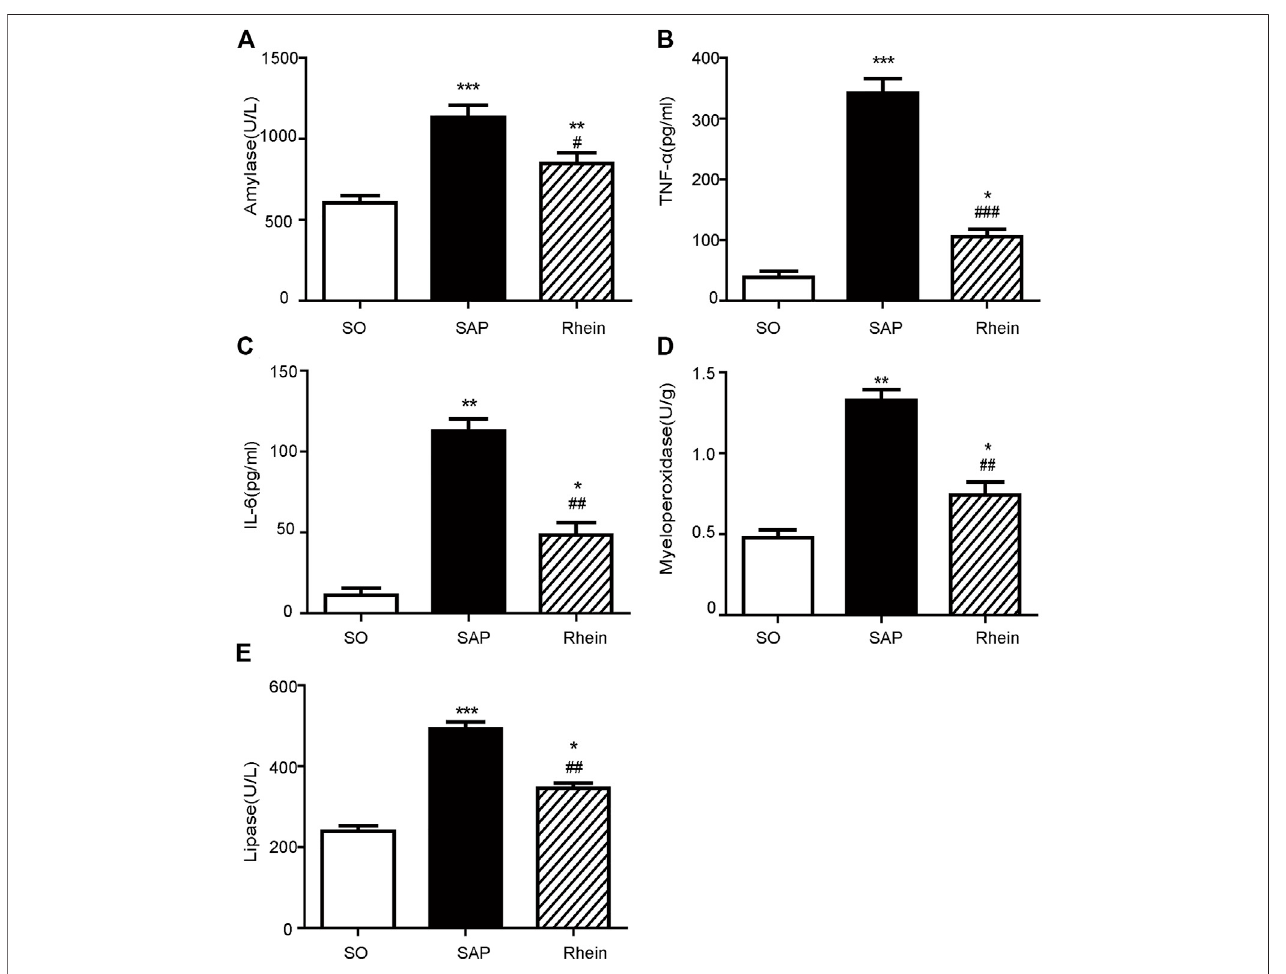
FIGURE3| Effectsofrheinonthein fl ammatorycytokinelevelsinpancreatictissueoftheSAPratmodel. (A) SerumamylaselevelsintheSO,SAPandrheingroups. (B) Serum TNF- α levels in the SO, SAP and rhein groups. (C) Serum IL-6 levels in the SO, SAP and rhein groups. (D) Myeloperoxidase levels in the SO, SAP and rhein groups. (E) SerumlipaselevelsintheSO,SAPandrheingroups.Dataareexpressedasmean±SD( n =5pergroup).Signi fi cancebetweengroupswasevaluatedbyone wayanalysisofvariance(ANOVA)followedbyaTukeyposthoctest.* p < 0.05,** p < 0.01and*** p < 0.001compared withtheSOgroup; # p < 0.05, ## p < 0.01and ### p < 0.001 compared with the SAP group. SO, sham operation; SAP, severe acute pancreatitis; TNF- α , tumour necrosis factor- α ; IL-6,